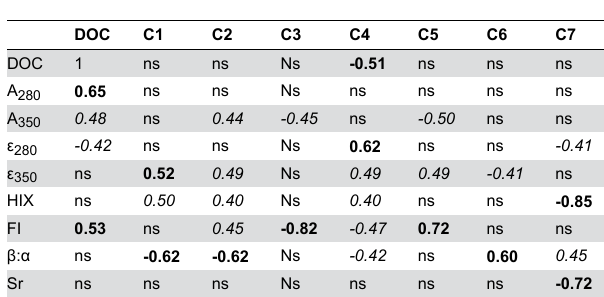
Table 3. Pearson’s correlation coefficient (r) between DOC concentrations and UV-Visible absorbance and fluorescence indices for 25 urban ponds in August, prior to photo-irradiation (T0).